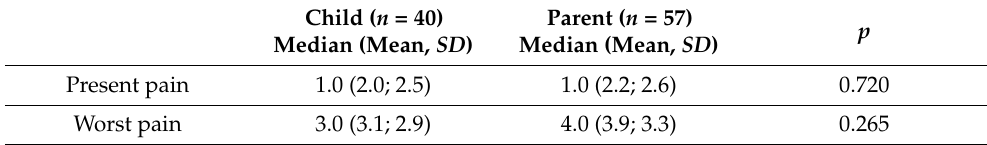
Table 3. Present and worst pain on VAS (range 0–10) for children with TS and their parents.